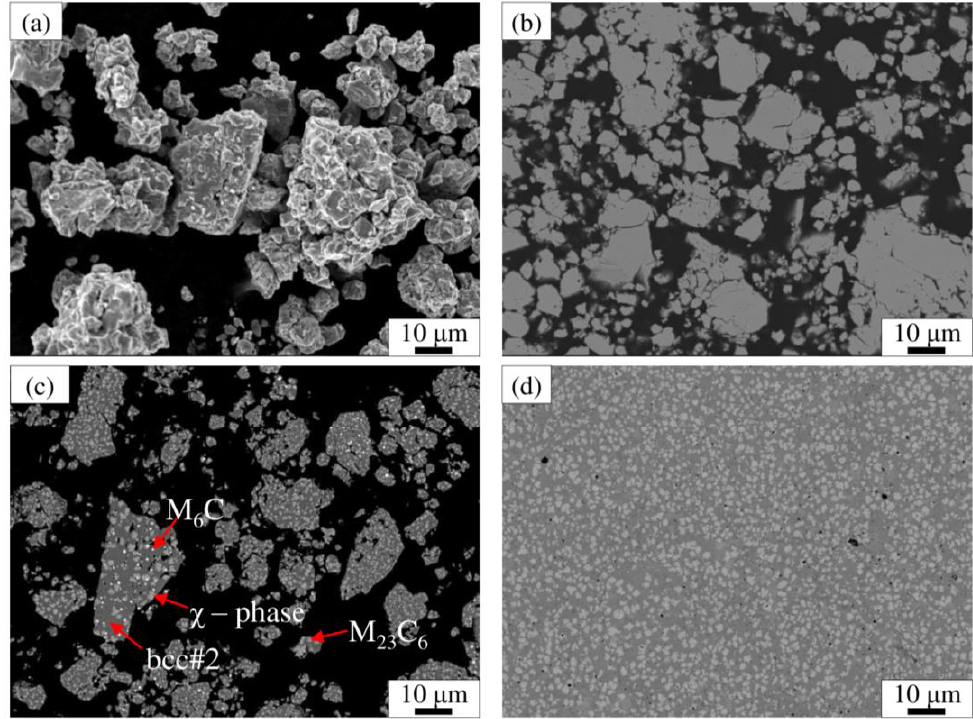
Figure 3. SEM images: ( a ) MA non-polished powder; ( b ) MA powder; ( c ) annealed powder; ( d ) sintered sample.